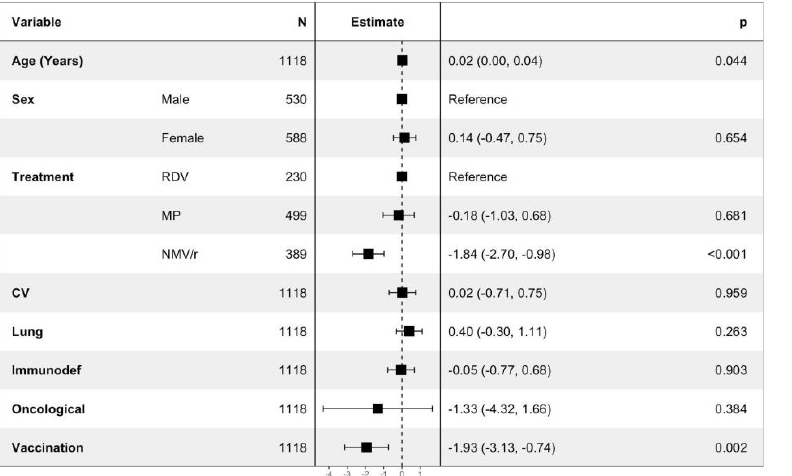
Figure 4. Linear regression analysis of time to negativization . RDV: remdesivir; MP: molnupiravir; NMV/r: nirmatrelvir/ritonavir; CV: cardiovascular disease; Immunodef: immunodeficiency.